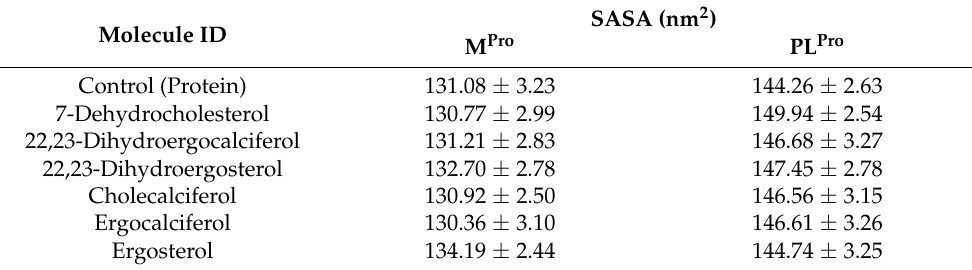
Table 5. Solvent accessible surface area (SASA) of Mpro and